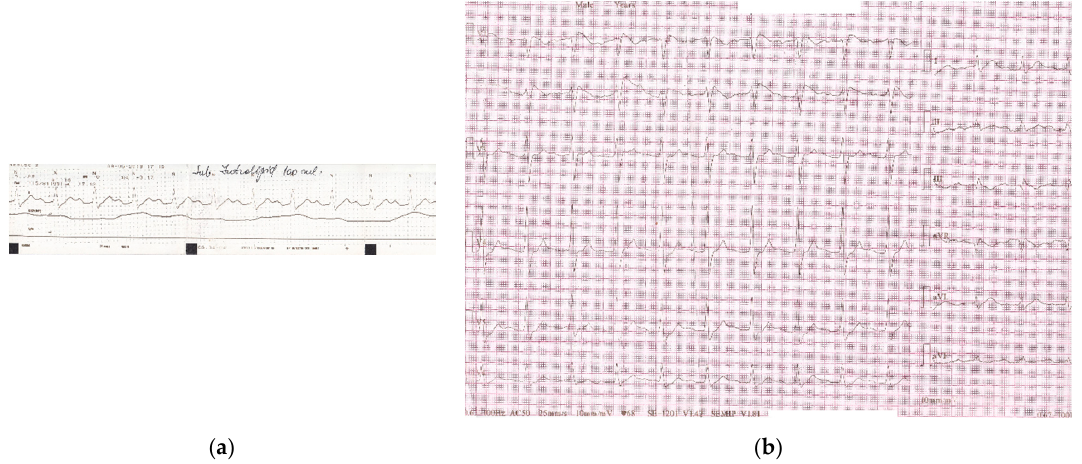
Figure 3. ( a ) Monitor recording during first 100 mL Intralipid ® solution revealing reversal of ECG changes: sinus rhythm 68/min with distinct visible P waves, prolonged PR interval 320 msec, wide QRS complex 160 msec, QT interval 480 msec; (b)12-lead ECG recorded after administration of the first 100 mL Intralipid ® : sinus rhythm 71/min, first degree AV block (PR interval 320 msec), wide QRS complex RBBB-type 180 msec, disappearance of negative T waves in aVF, corrected QTc interval 479 msec.